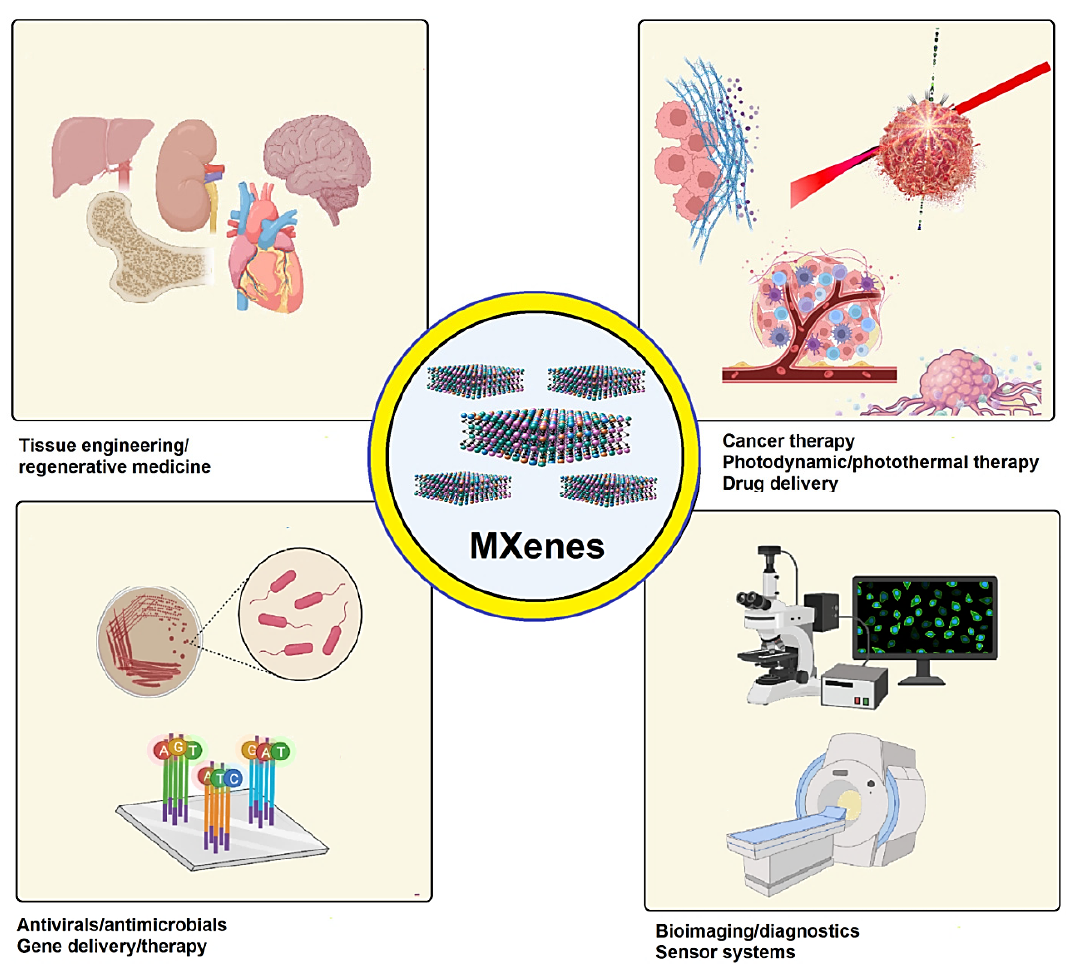
Figure 1. MXenes and their derivatives with versatile biomedical potentials.